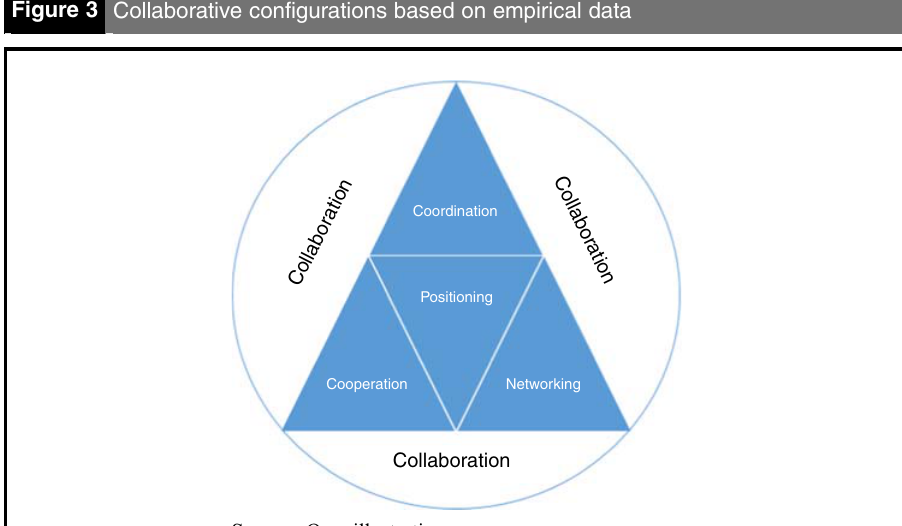
Figure 3 Collaborative configurations based on empirical